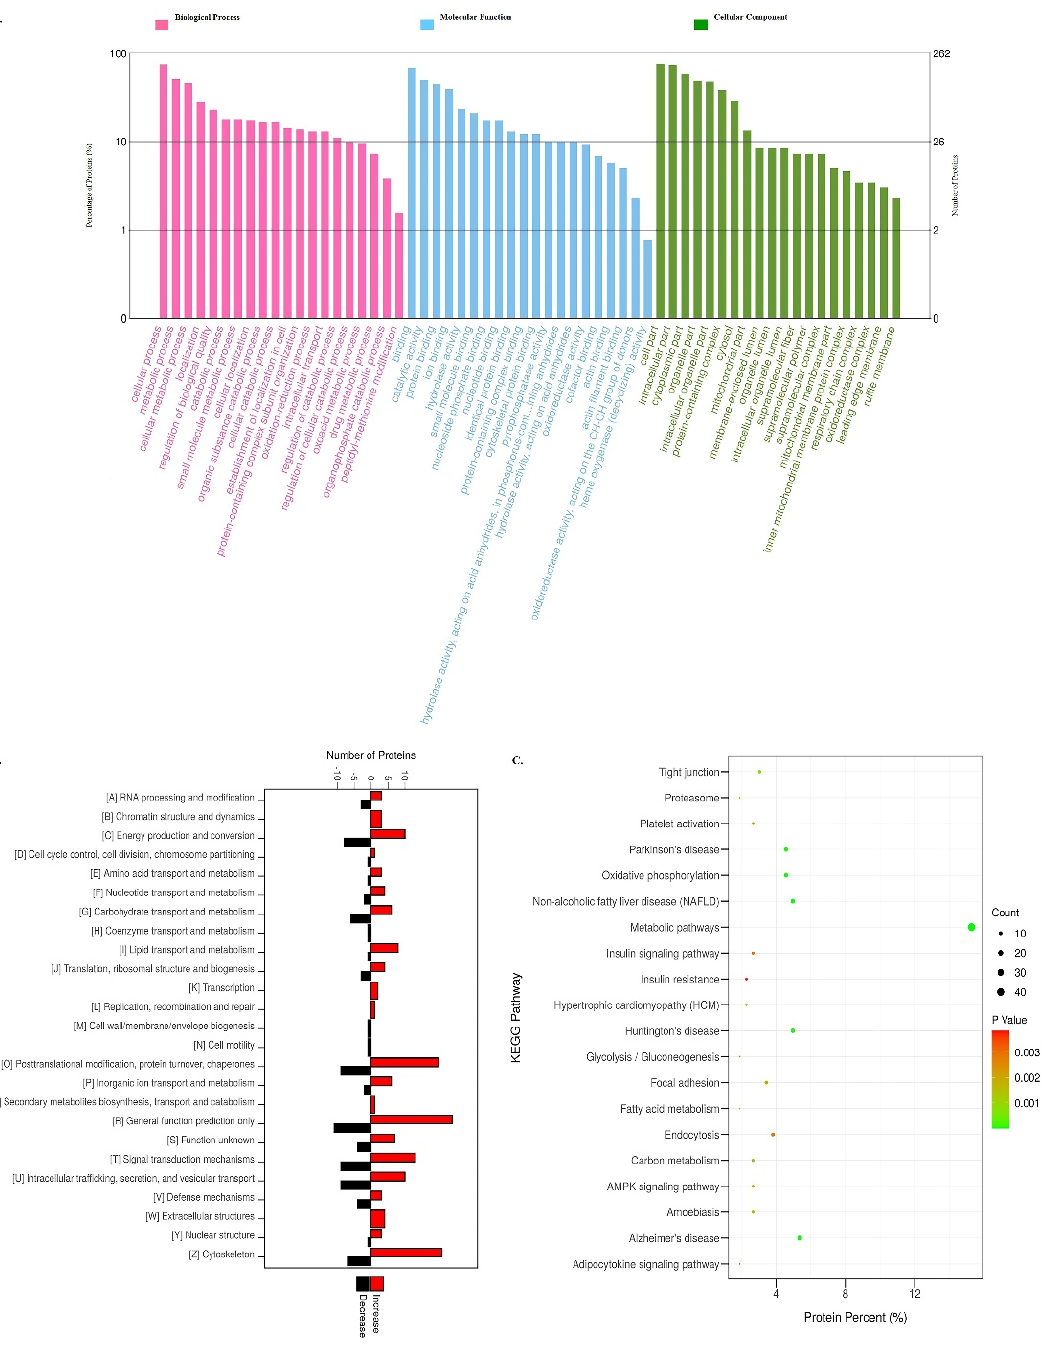
Figure 3. ( A ) Gene ontology (GO) classification of differentially expressed proteins in frozen beef vs. CON group. ( B ) KOG analysis of DAPs (x-axis displays DAPs count, y-axis displays KOG terms) in frozen beef vs. CON group. ( C ) KEGG pathway of DAPs in frozen beef vs. CON group.